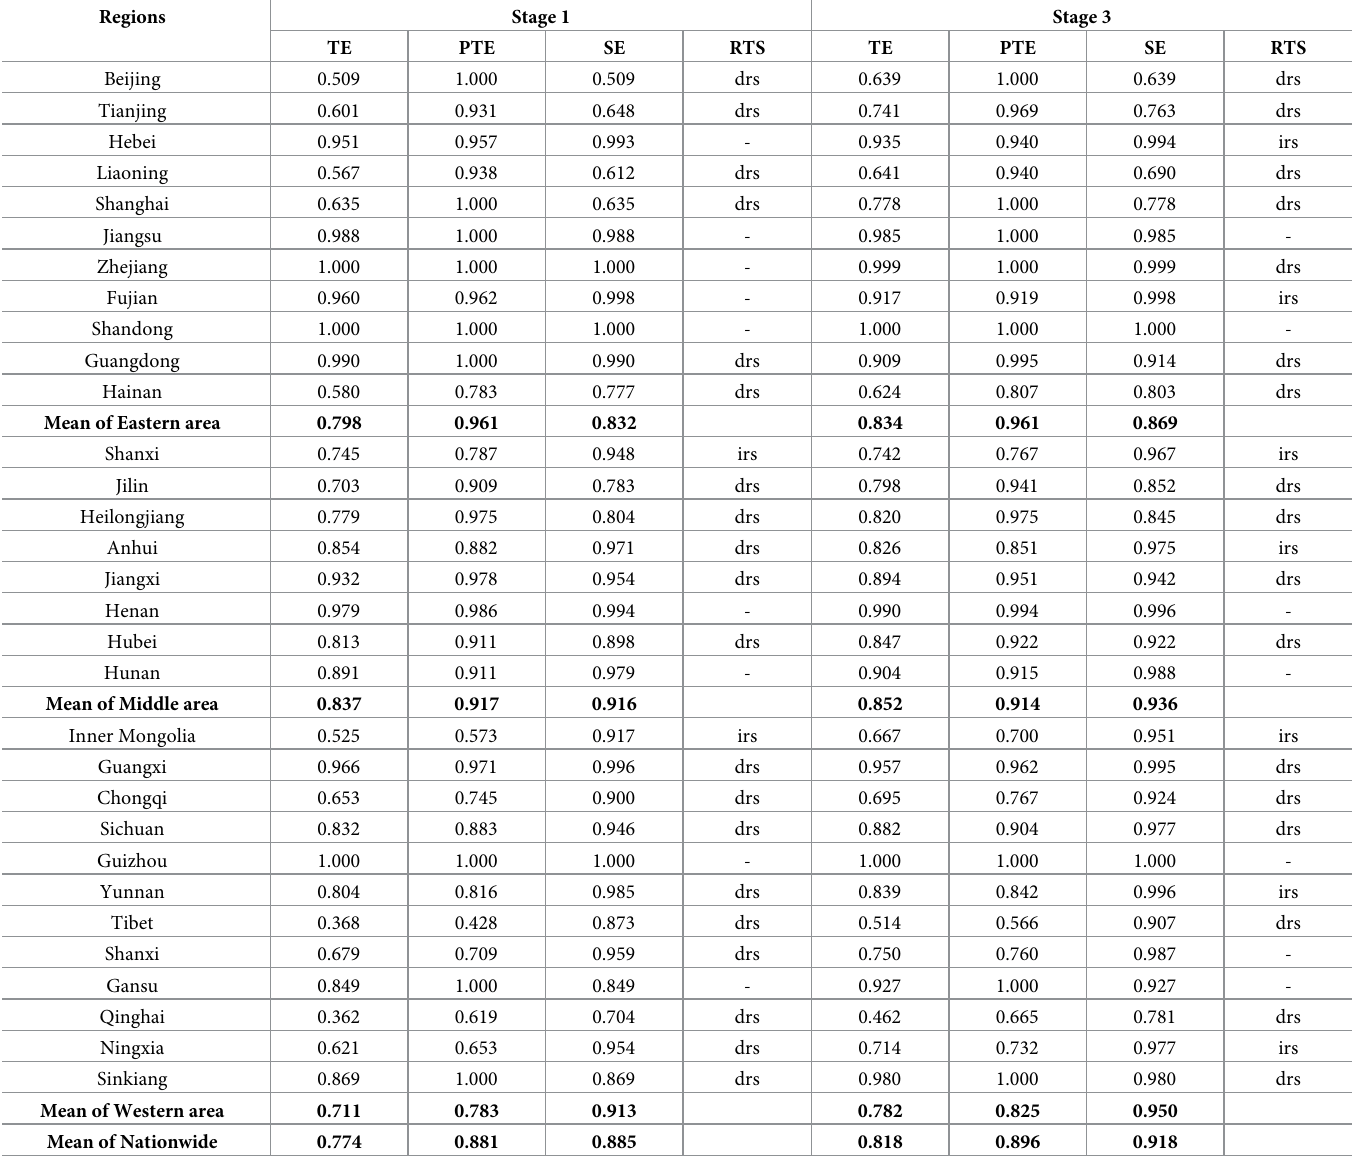
Table 5. DEA efficiency of the 31 provinces/municipalities prior to and following the adjustment.